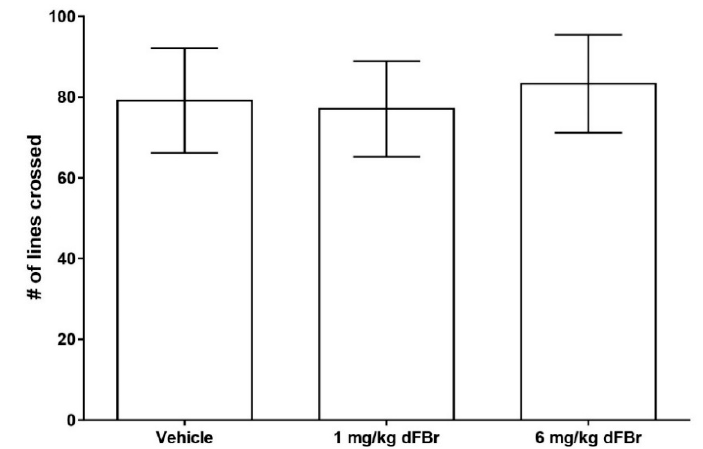
Figure 4. Desformylflustrabromine (dFBr) does not cause a significant change in the number of lines crossed in the open field exploration test. The number of lines crossed is expressed as mean ( ± S.D.). Statistical significance was considered as p < 0.05. Twelve mice were included in each treatment group ( n = 12).